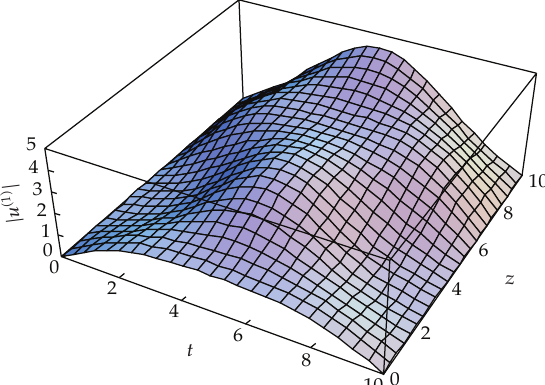
Figure 35: The first-order approximation of | u (cid:3) 1 (cid:4) | at α (cid:8) 1, T (cid:8) 10, γ (cid:8) 0, ε (cid:8) 05 with considering only one term in the series (cid:3) M (cid:8) 1 (cid:4) .